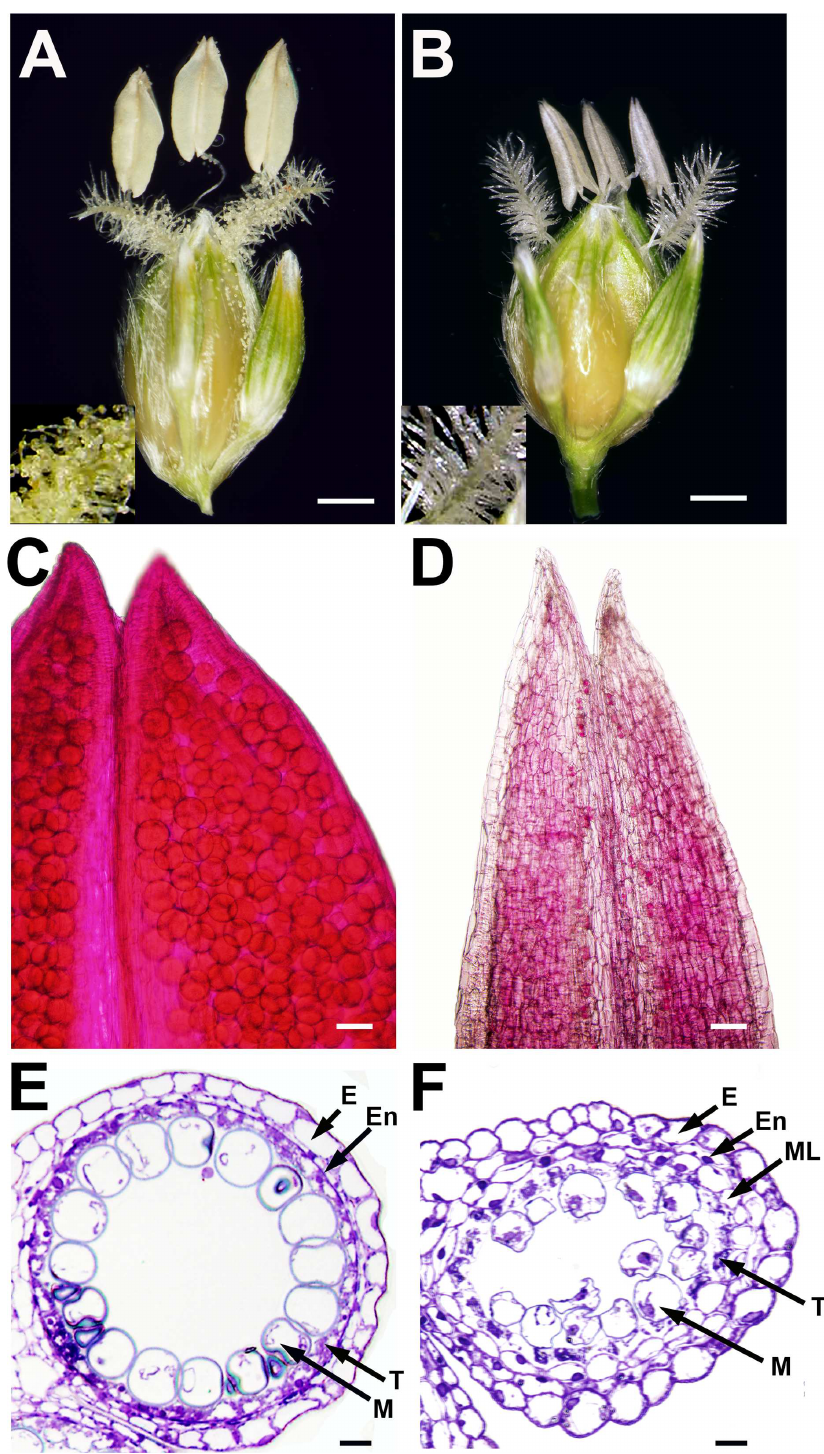
Fig 4. Morphological analysesof pollen and anther development in BTx623 wild-type and ms8 mutant plants. (A) A BTx623 sorghum spikelet with three mature anthers. Pollengrains released from anthers and stacked on hairy stigmas ( A , inset). (B) An ms8 mutant spikelet with three pale and flattened anthers. No pollengrains on the ms8 stigma ( B , inset). (C) A part of BTx623 anther showinground pollengrains inside anther lobes. (D) A part of ms8 mutant anther showingno pollengrains insideanther lobes. (E) A